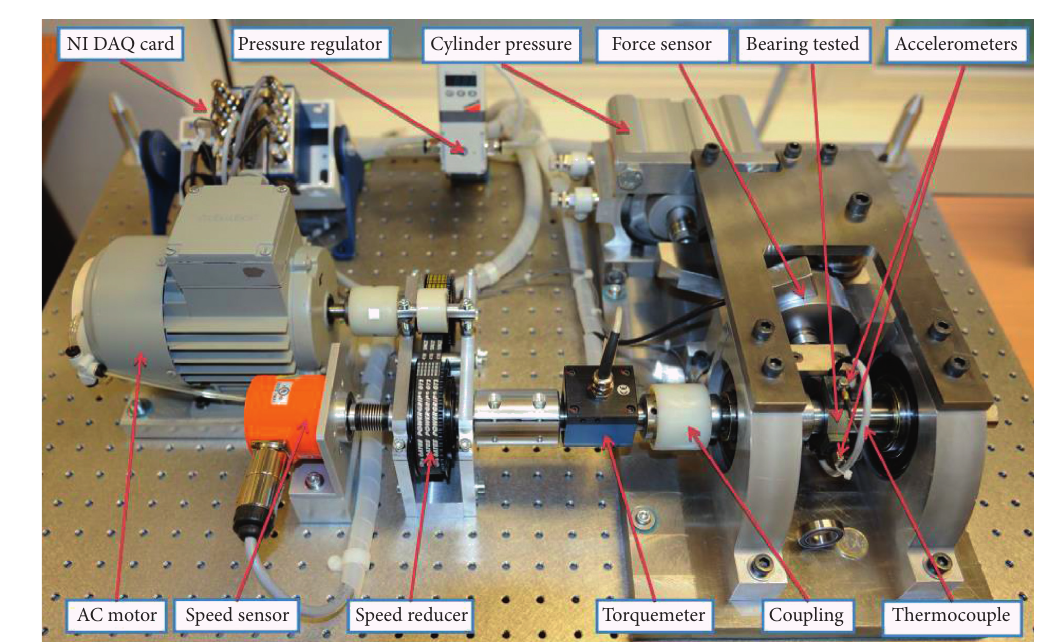
Figure 4: Overview of the PRONOSTIA experimental